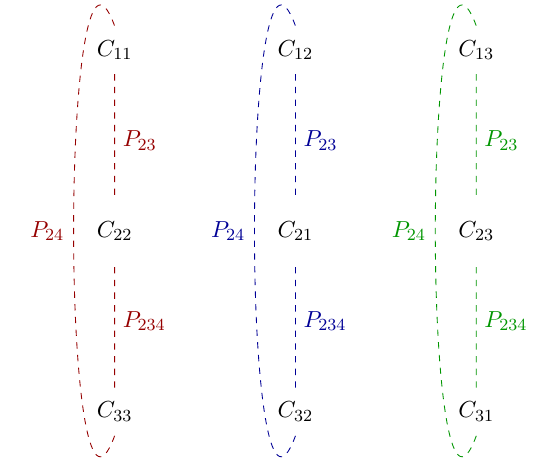
Fig. 1 Orbits of the primary CWI’s of the T OOO under P 23 and P 24